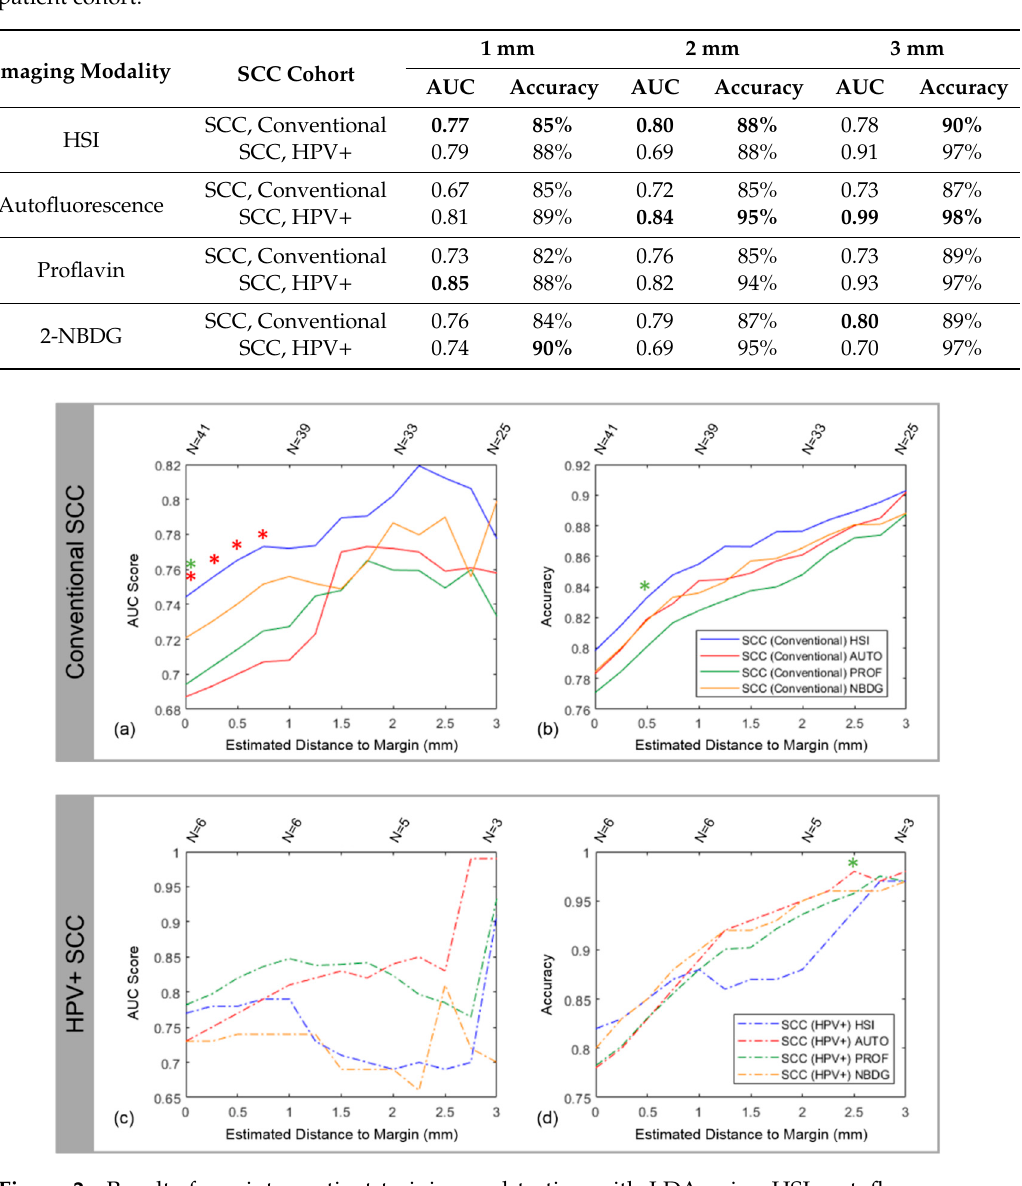
Table 2. Accuracy and area under the curve (AUC) results for the optical imaging modalities performed using the intra-patient experiments for conventional SCC and human papilloma virus (HPV + ) p16-positive cohorts. Bolded values represent the greatest value in the column for each patient cohort.